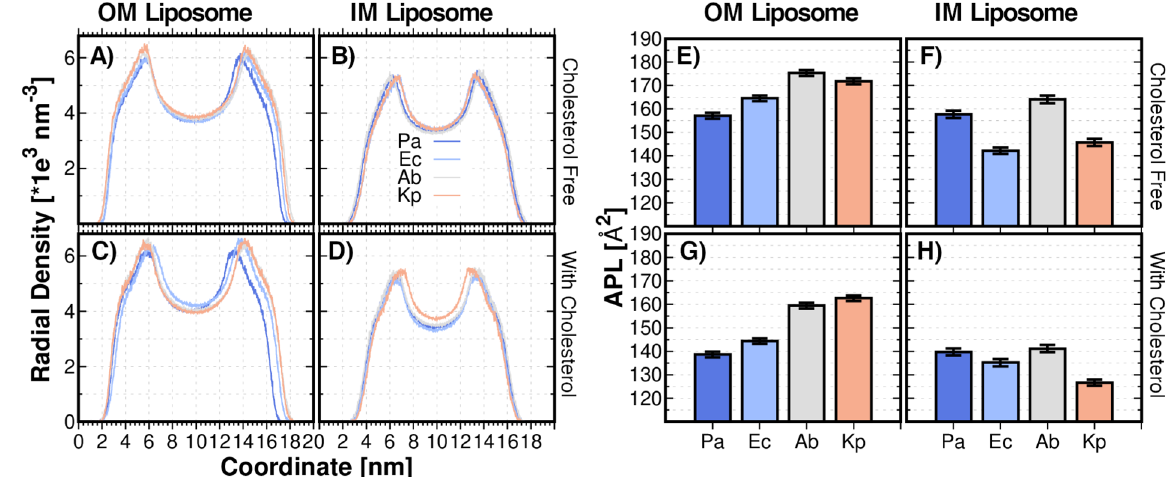
Figure 2. Liposome Components Density and APL. Liposome components density for, (A – B) both OM and IM liposomes respectively; (C – D) OM and IM liposomes containing cholesterol, respectively. APL measurements for, (E – F) both OM and IM liposomes, respectively; and, (G – H) OM and IM liposomes containing cholesterol, respectively. Kp: K. pneumoniae . Ab: A. baumannii. Pa: P. aeruginosa . Ec: E. coli . Analysis performed on the last μs of the MD